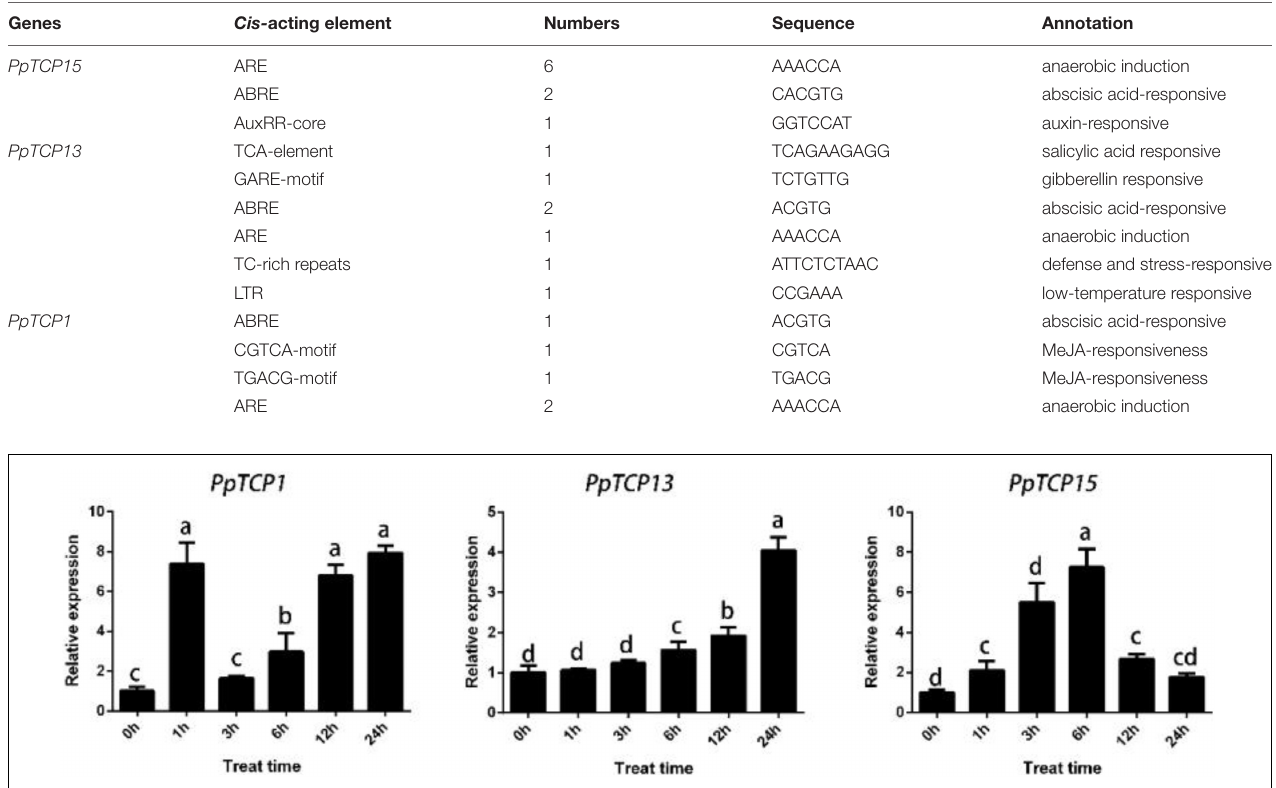
FIGURE 6 | Expression patterns of PpTCP1 , PpTCP13 , and PpTCP15 after ABA treatment. One-year-old peaches were sprayed with 100 µ M ABA, and samples were taken at 0, 1, 3, 6, 12, and 24 h for qRT-PCR analysis. Biological triplicates were performed for each sample. Different letters represent significant differences according to ANOVA and Duncan’s test ( P <